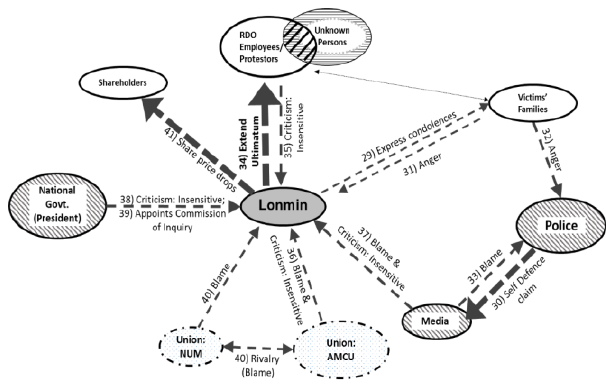
Figure 7: Stakeholder model for Lonmin (Period 17 to 24 August)